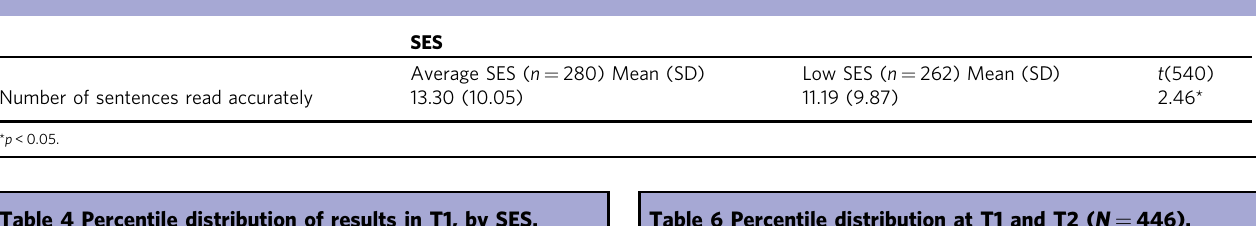
Table 3 Average of correct answers by educational territory in T1.